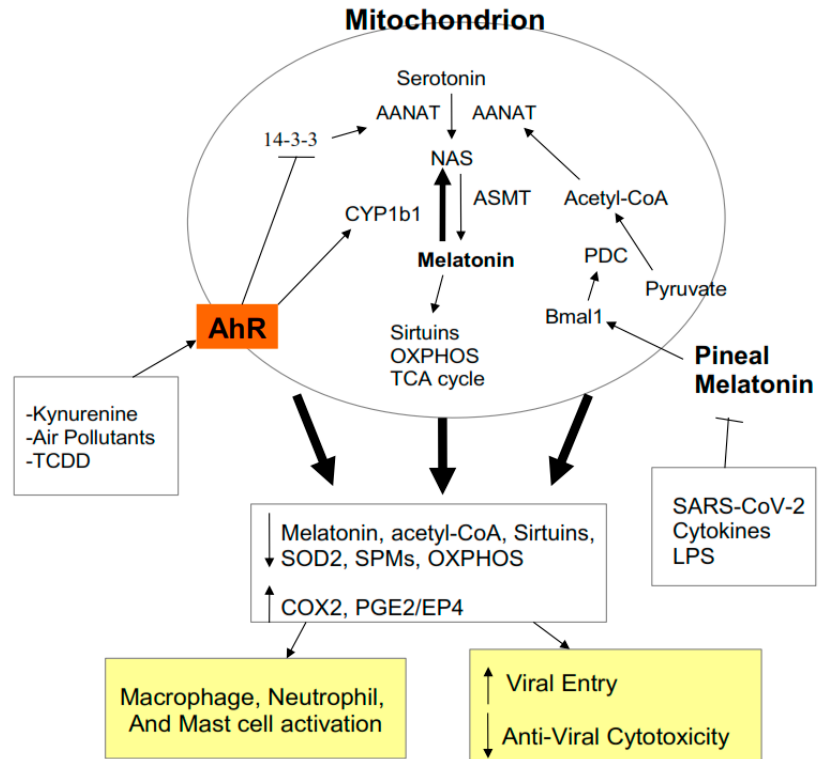
Figure 3. AhR activation contributes to alterations in mitochondrial metabolism as does suppressed pineal melatonin. By increasing CYP1B1 and suppressing 14-3-3, AhR activation lowers mitochondrial and cytoplasmic melatonin, thereby decreasing sirtuins and superoxide dismutase (SOD)2, contributing to suboptimal mitochondrial function. The decrease in circadian pineal melatonin in the aged, as well as from increased cytokines and gut permeability, lowers Bmal1 induction, which is crucial to upregulating pyruvate dehydrogenase complex (PDC) and its conversion of pyruvate to acetyl-CoA. Acetyl-CoA is a necessary co-substrate of AANAT and therefore for the initiation of the melatonergic pathway. The release of melatonin by cells of the ‘cytokine storm’ is necessary for their switch to a quiescent / phagocytic phenotype and this seem co-ordinated with SPMs induction. Acetyl-CoA is necessary for optimized oxidative phosphorylation (OXPHOS) and tricarboxylic acid (TCA) cycle ATP production. Acetyl-CoA also inhibits the COX2 / PGE2 / EP4 pathway that underpins exhaustion and is necessary for the increase in glycolysis that is required for anti-viral cells to become activated. The AhR and pineal melatonin act to regulate immune cell metabolism, activity and response to viral